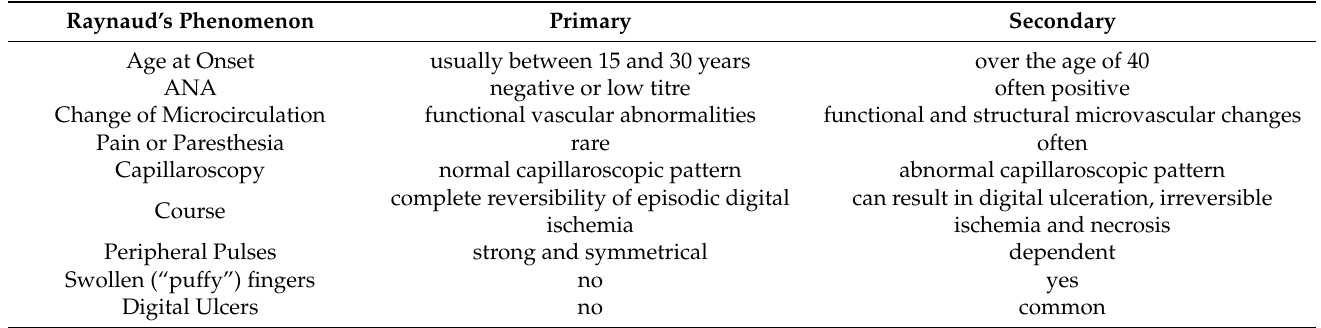
Table 1. Differences between primary and secondary Raynaud’s phenomenon [3,5,6,8,9]; ANA— antinuclear